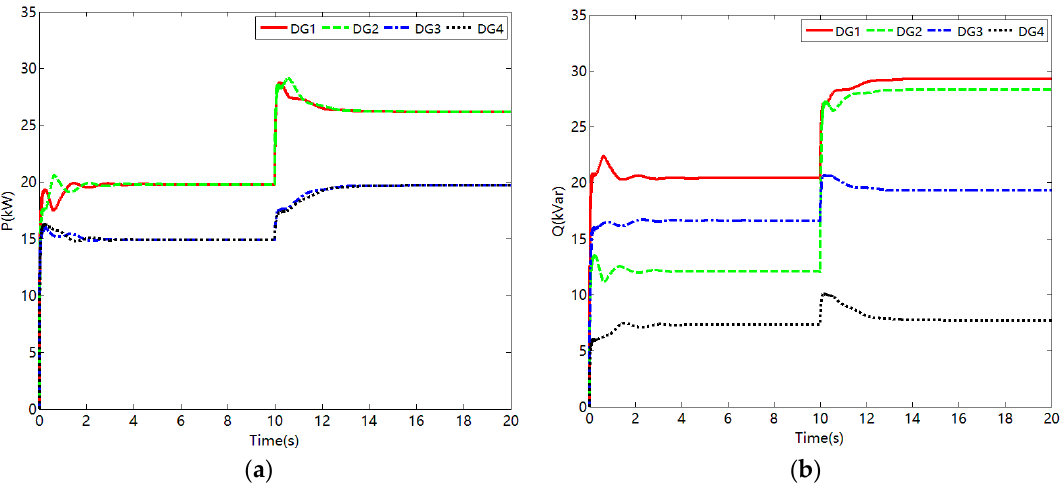
Figure 12. Simulation results with time-delays and disturbances. ( a ) Active power; ( b ) reactive power.